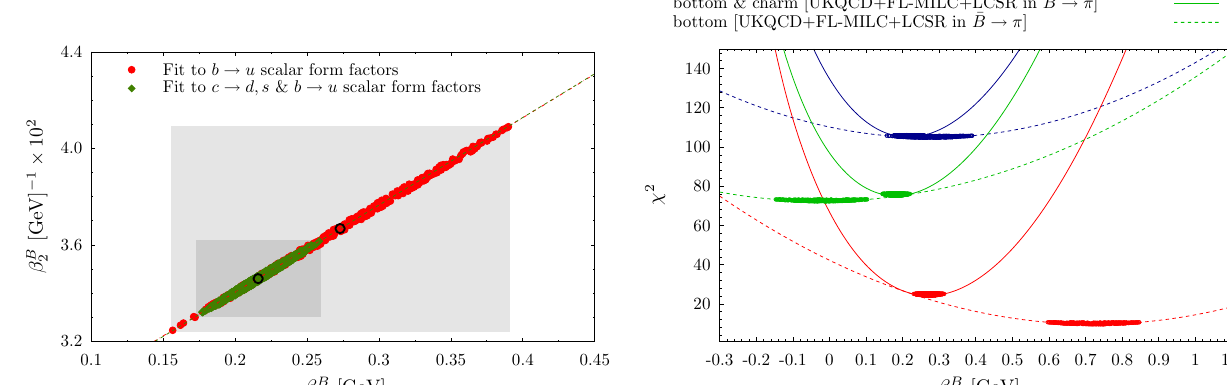
β B 1 [GeV] Fig. 10 Left plot: statistical 68% CL ellipses and one-sigma-rectangle ations. The circles stand for the different best-fit results, accounting for ,β B ) − plane obtained by minimizing the merit func- bands in the (β B variations of χ 2 up to 1 unit from the minimum value, while the dashed 1 2 tions given in Eqs. (49) and (55). In addition the correlation relation of and solid curves have been obtained by relating β B Eq. (52) is also displayed. A similar relation deduced from the best-fit Eq. (52) and minimizing χ 2 with respect to the other parameters, β 0 ,δ results of Table 4 is also shown, though it is hardly distinguishable from and δ (cid:5) , the former one. Right plot: Dependence of χ 2 on β B for different situ- 1